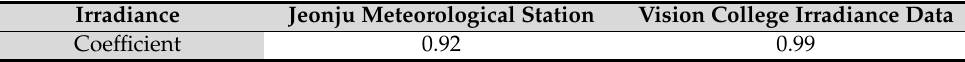
Table 4. Pearson correlation coefficients of location difference irradiance and SPV power